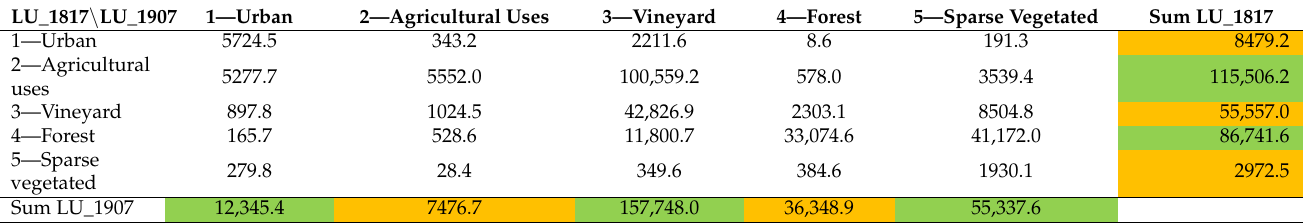
Table 6. Contingency table of land cover change for the period 1817–1907. Results represent the areas under change and are expressed in ha. Cells in orange report a loss in ha, while green ones report a net gain in